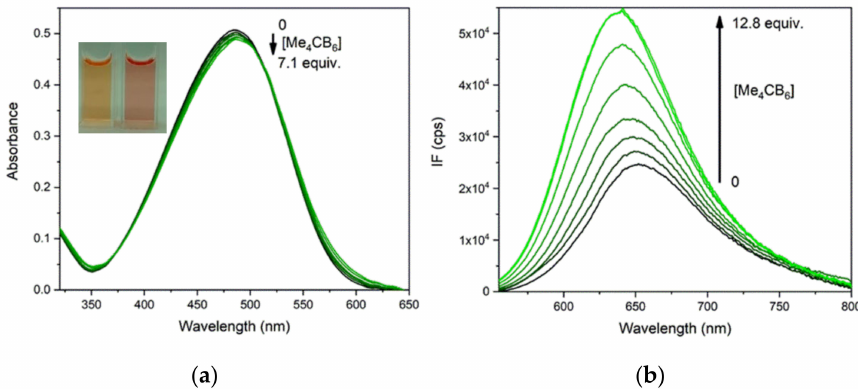
Figure 9. ( a ) Absorption and ( b ) fluorescence spectra of PhSt in pH 8.0 bu ff ers in the presence of Me 4 CB6 in di ff erent concentrations. Initial concentrations of PhSt ( a ) 1.5 × 10 − 5 M. ( b ) 1.0 × 10 − 6 M, λ ex = 510 nm, the isosbestic point of the absorption